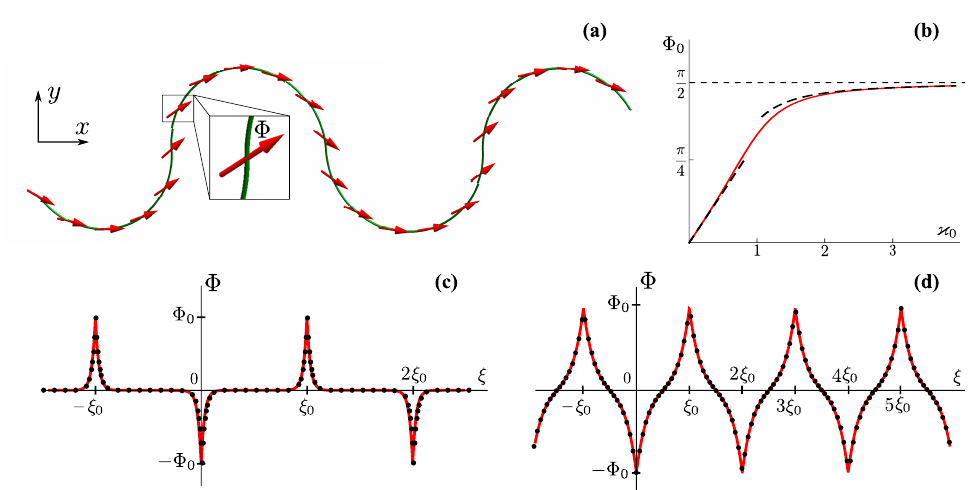
Figure 2: Equilibrium state of magnetization: (a) Spatial distribution of magneti- zation (red arrows) along the wire; the inclination angle Φ is shown in the inset. The analytical solution (3b) (line) is compared to the result of numerical minimization = 0.1 (c) and (cid:99) = 0.6 (d). The maximal am- of energy (1b) (dots) for the cases (cid:99) 0 0 plitude Φ of the magnetization deviation from the tangential direction is plotted as 0 a function of (cid:99) in the inset (b): the dashed lines correspond to asymptotes Φ 0 (cid:16) (cid:17) ≈ π (cid:28) 1 and (cid:99) (cid:29) 1, and Φ 1 − 1 valid for the cases (cid:99) 0 0 0 2 4 (cid:99) 2 0